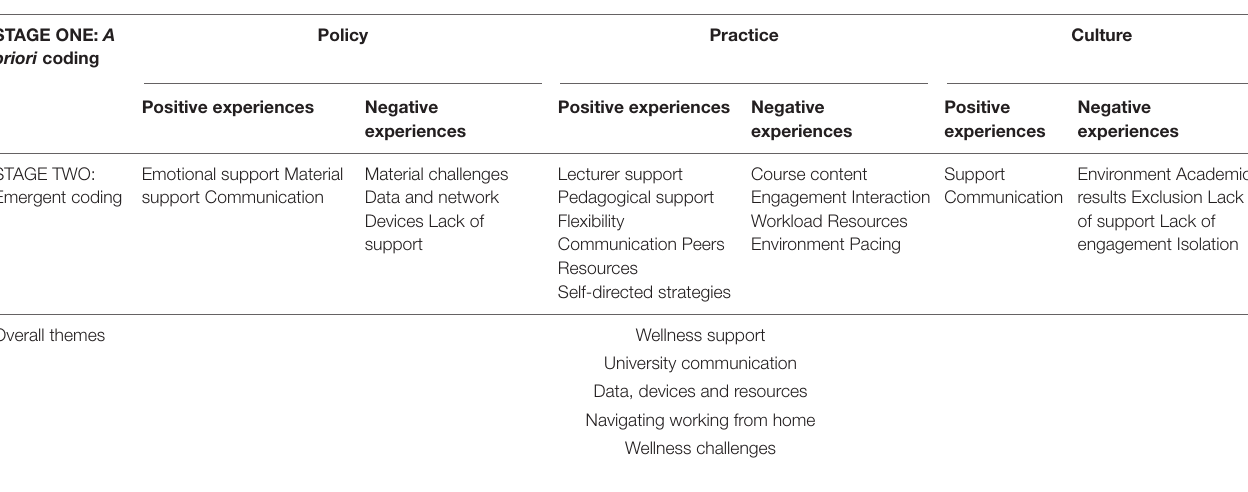
TABLE 1 | Coding. STAGE ONE: A priori coding